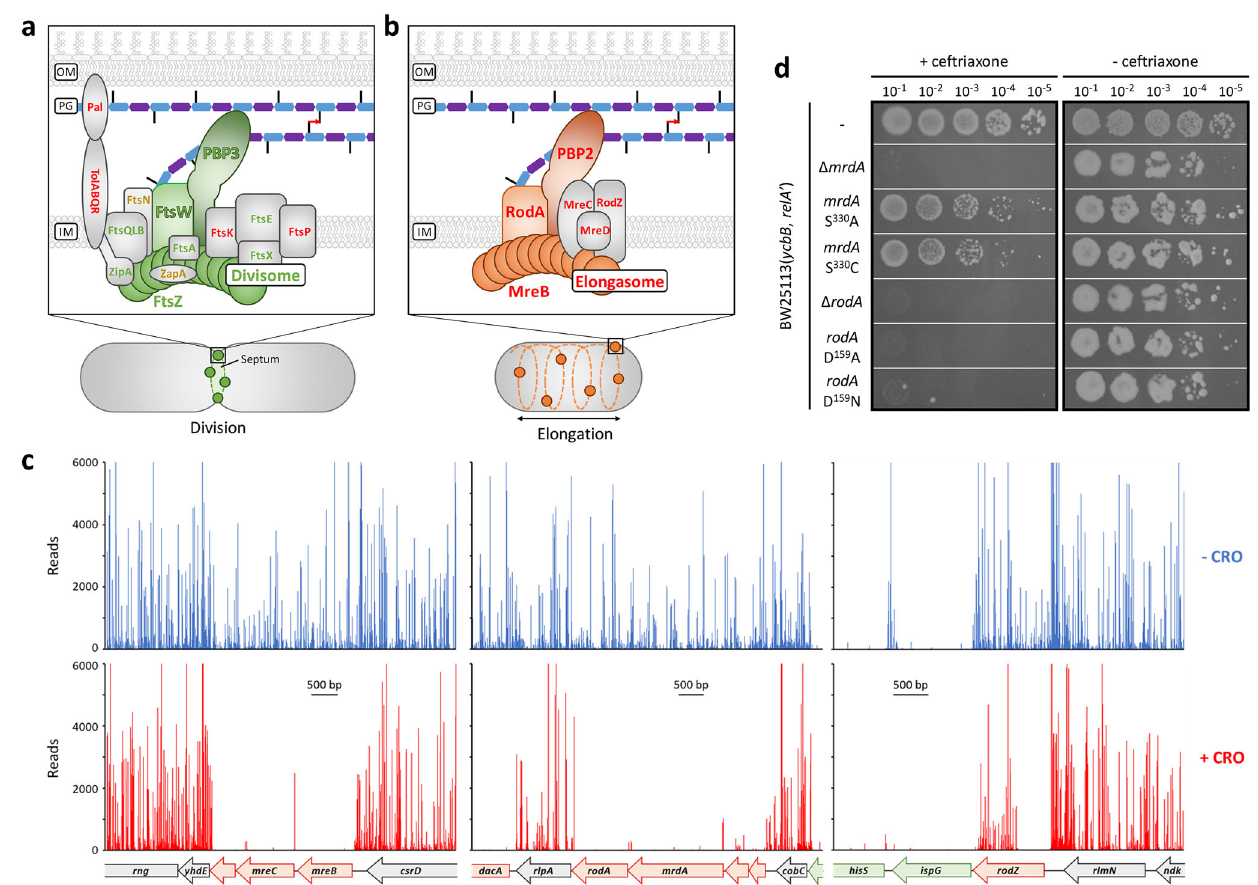
Fig. 3 | Tn-seq evaluation of genes encoding components of the PG poly- merization complexes. a , b Schematic representation of the divisome and elon- gasome,respectively. c Tn-seqinsertionpro fi